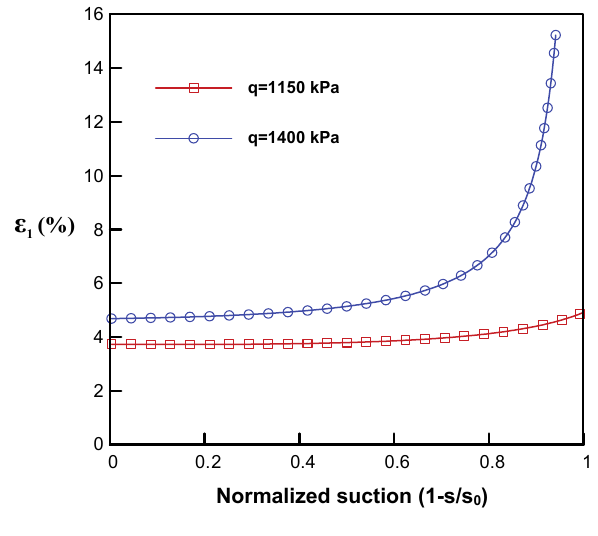
Fig. 7. Variation of vertical strain ( ε 1 ) against normalised suction (1 – s / s 0 ) due to soaking at q = 1150 kPa and 1400